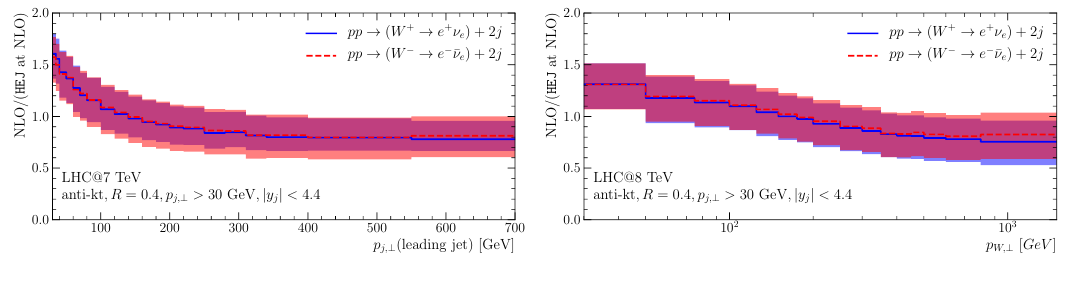
Figure 1: The NLO-matching corrections for distributions presented in [ 16, 17 ] for inclusive W + + 2 j production (blue, solid) and W − + 2 j production (red,